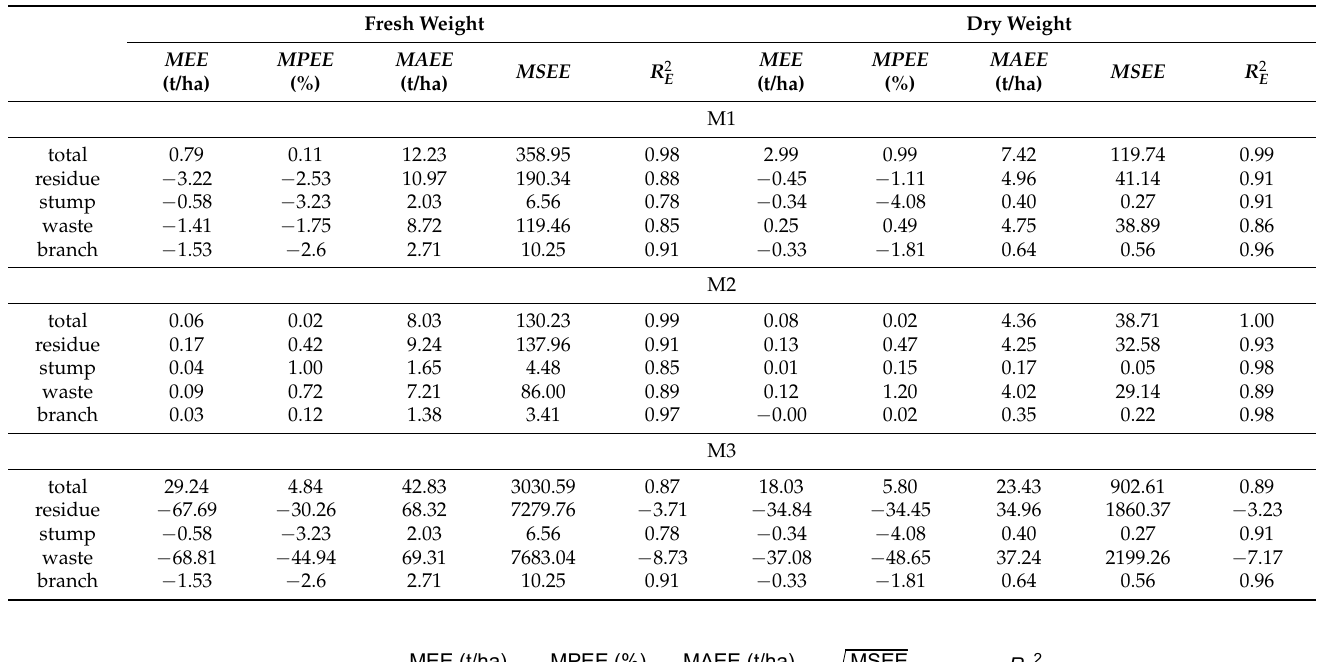
Table 2. Benchmarking statistics for the three methods of residue biomass estimation for all stand types combined.